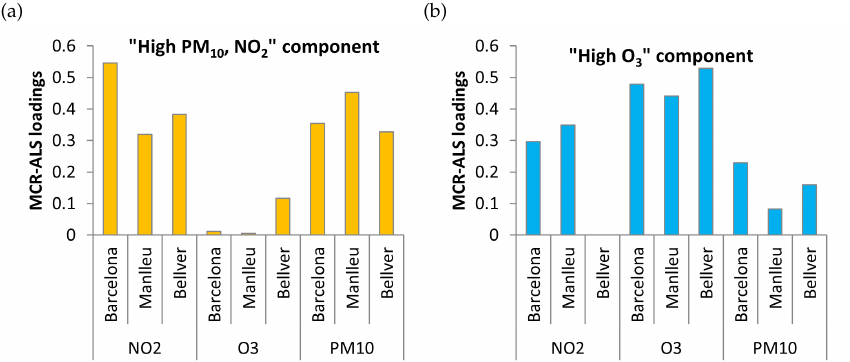
Figure A1. Loadings of the two components from the MCR-ALS analysis on the PM 10 , NO 2 , and O 3 data from Barcelona, Manlleu and Bellver de Cerdanya. ( a ) “High PM 10 , NO 2 ” component.